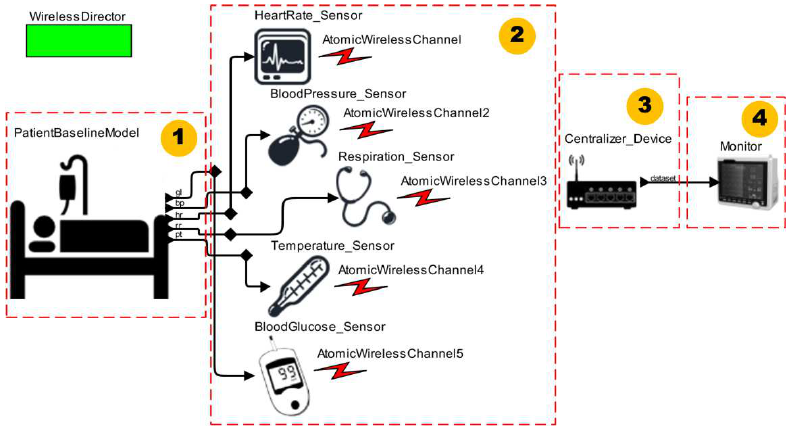
Figure 18. MCPS Model Using the ICU Patient